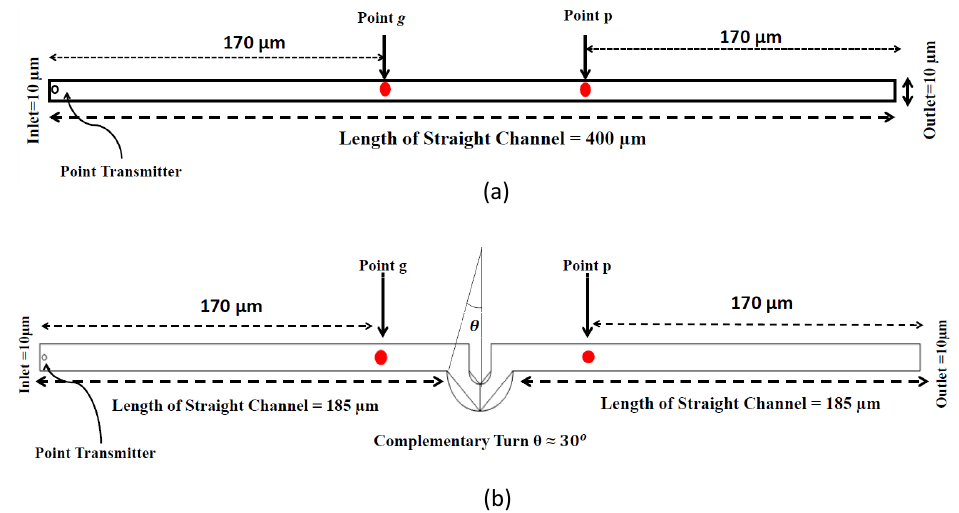
Figure 5. Geometry of ( a ) Straight Channel, ( b ) Inward turn (created using FEM software COMSOL Multiphysics 4.3a).